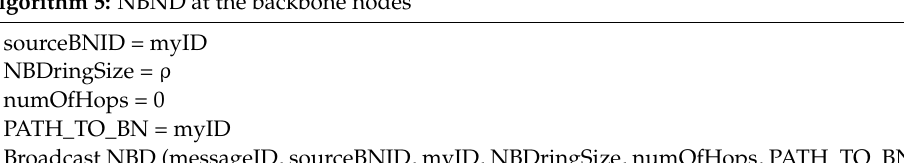
Algorithm 5: NBND at the backbone nodes